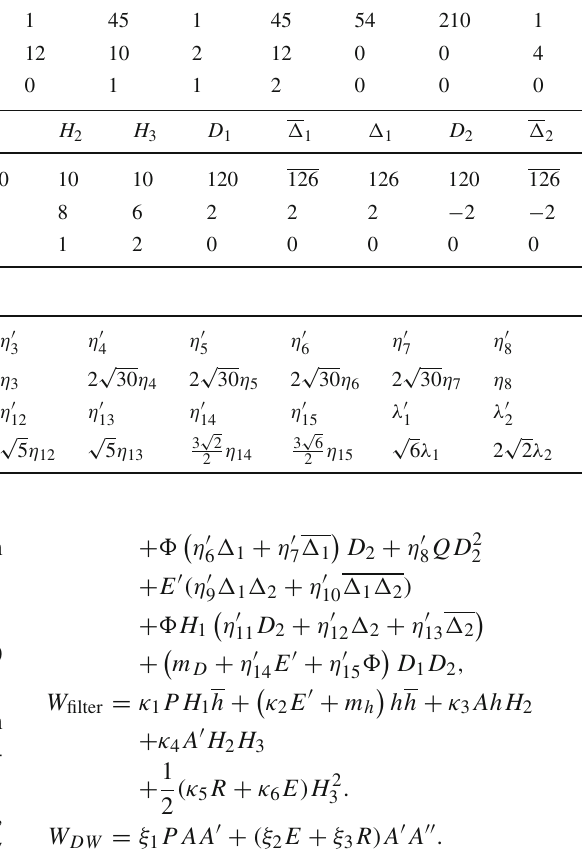
Table 1 Notations and Z 24 × Z 4 properties of all superfields. Here ψ i ( i = 1 , 2 , 3 ) are the matter superfields